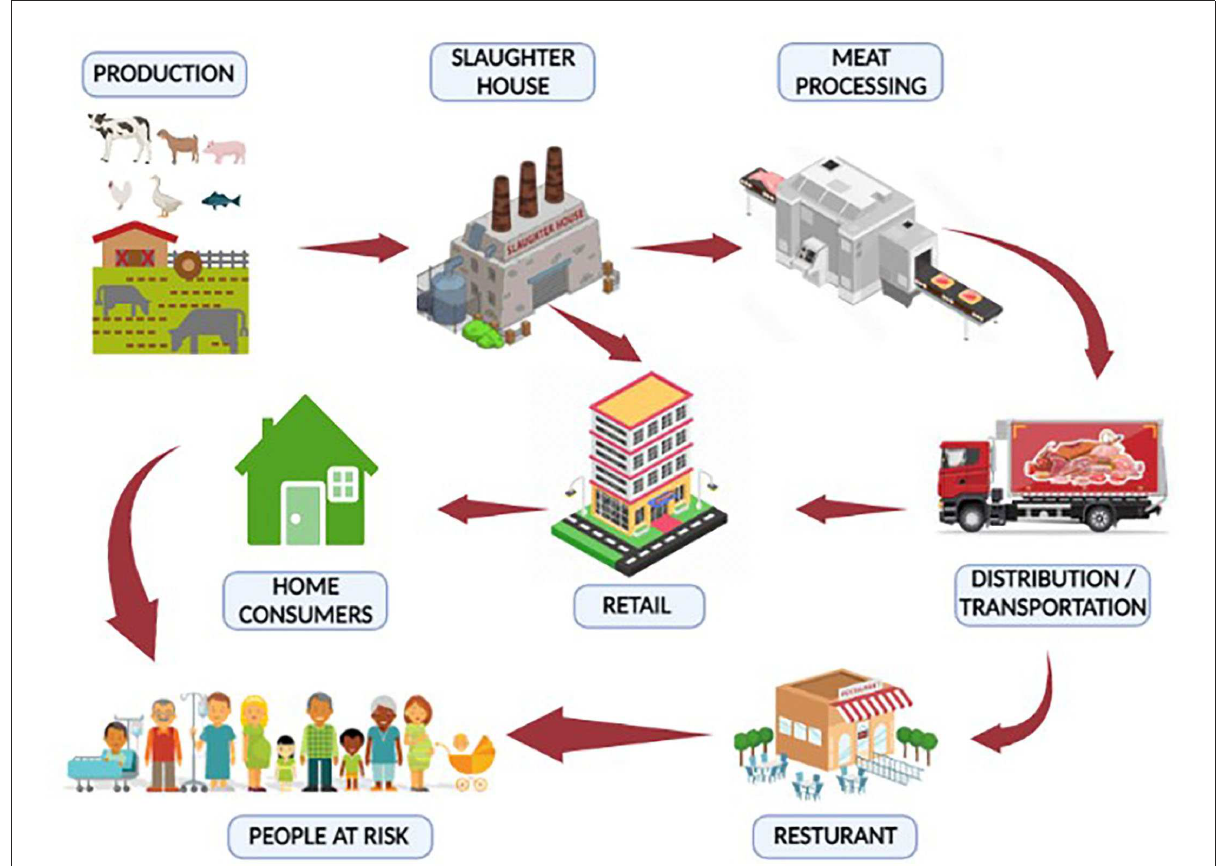
FIGURE3 Meat supply chain (farm to fork). Meat or meat products can be contaminated with bacterial pathogens from “farm to fork”. The meat supply chain includes a production system for animals, a slaughterhouse, a meat processing unit, transportation, a retail market, and a restaurant. Stringent control measures should be adopted to minimize contamination and, hence, meat-borne